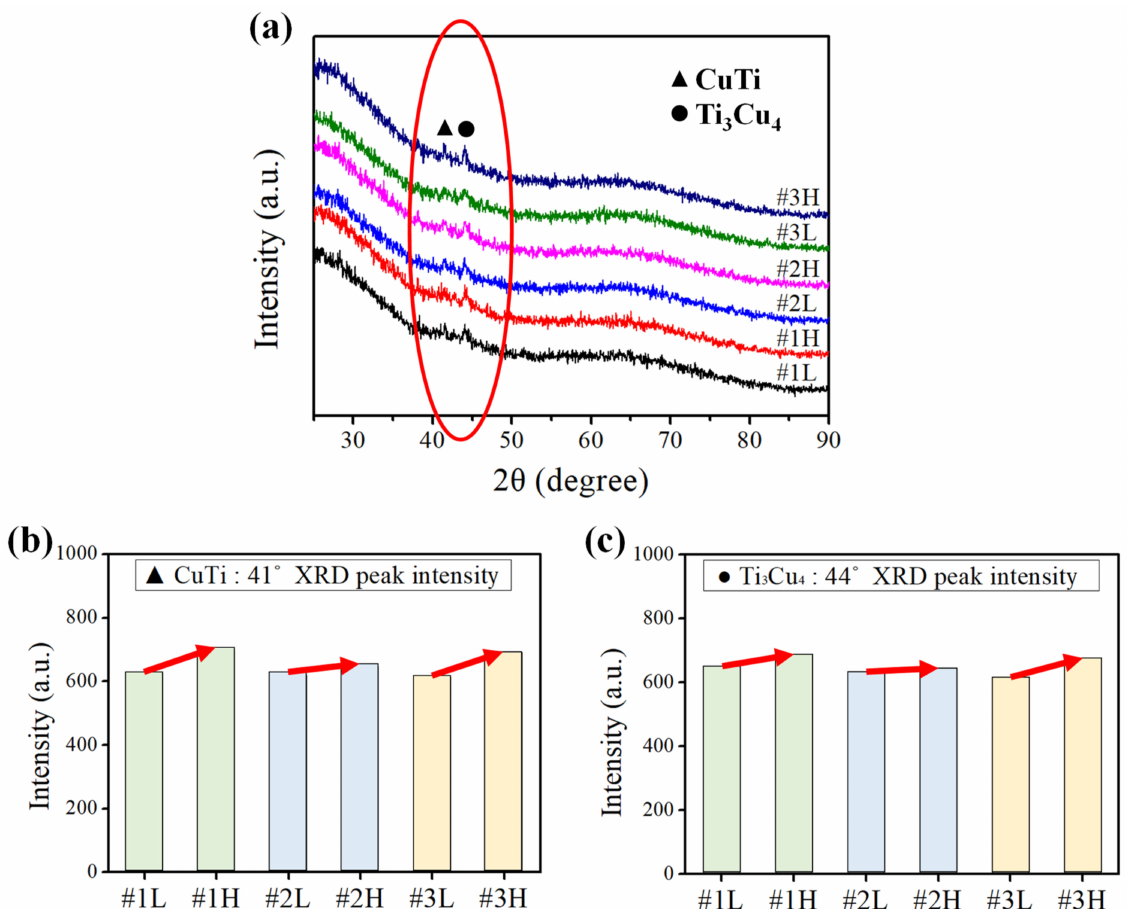
Figure 3. ( a ) X-ray diffraction patterns obtained from the Ti-based BMGs. ( b ) The 41 ◦ peak intensity (CuTi) and ( c ) 44 ◦ peak intensity (Ti 3 Cu 4